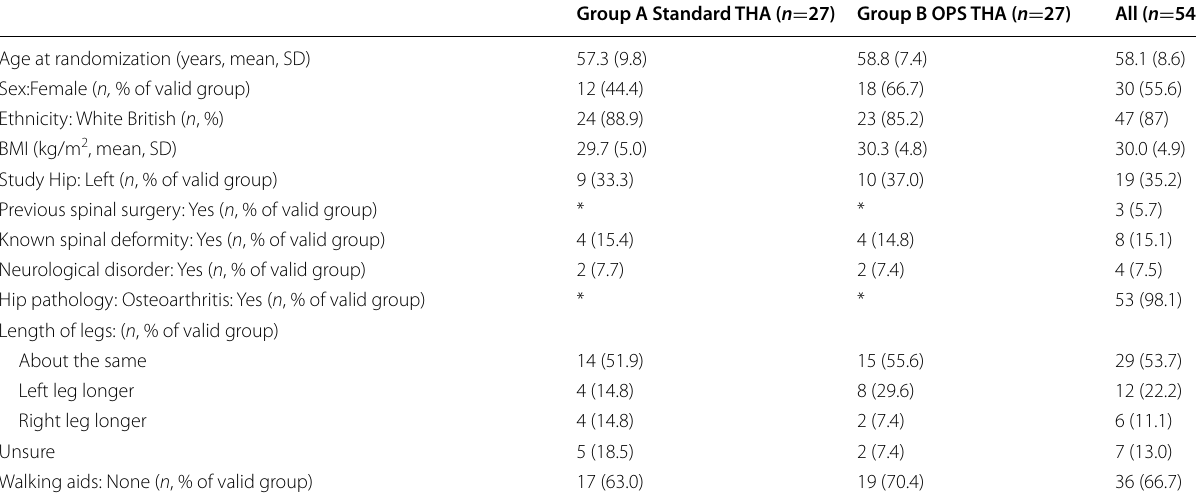
Table 1 Patient descriptive statistics at